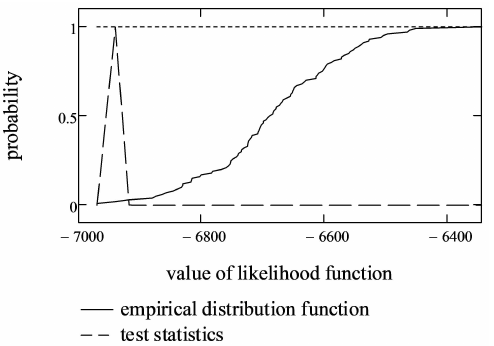
Figure 10. The empirical distribution function of LLF and test statistics of cryptocurrency